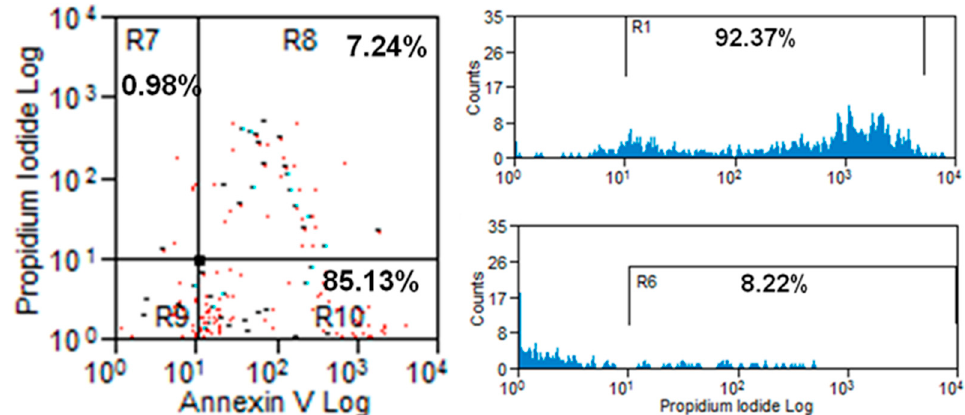
Figure 10. Flow cytometry of T. cruzi epimastigotes treated with 5 μ M of compound 27 for 24 h labelled with annexin V- Alexa 488 nm and propidium iodide. Approximately 85% of epimastigotes are marked with annexin V, indicating an onset of the apoptotic process. Of these, more than 90% are also marked with propidium iodide, indicating a loss of integrity of the plasma membrane.